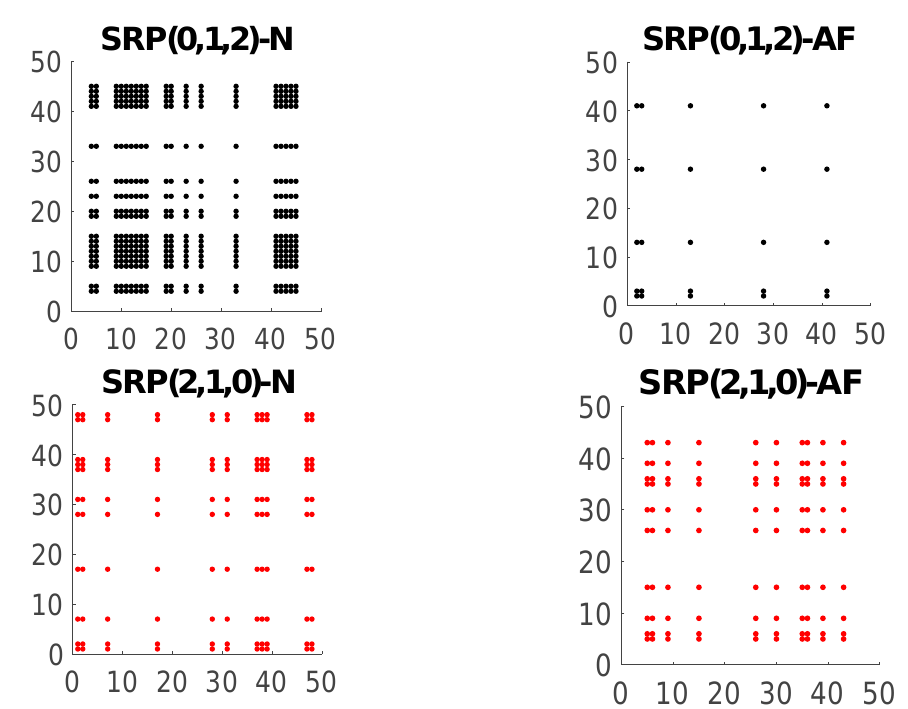
Figure 3. Symbolic recurrence plot (SRP) to increasing (first row) and decreasing (second row) symbols of an RR interval time series of length 50 for embedding dimension m = 3 of a patient in normal sinus ( left ) and another patient in atrial fibrillation ( right ). N denotes normal sinus and AF atrial fibrillation.